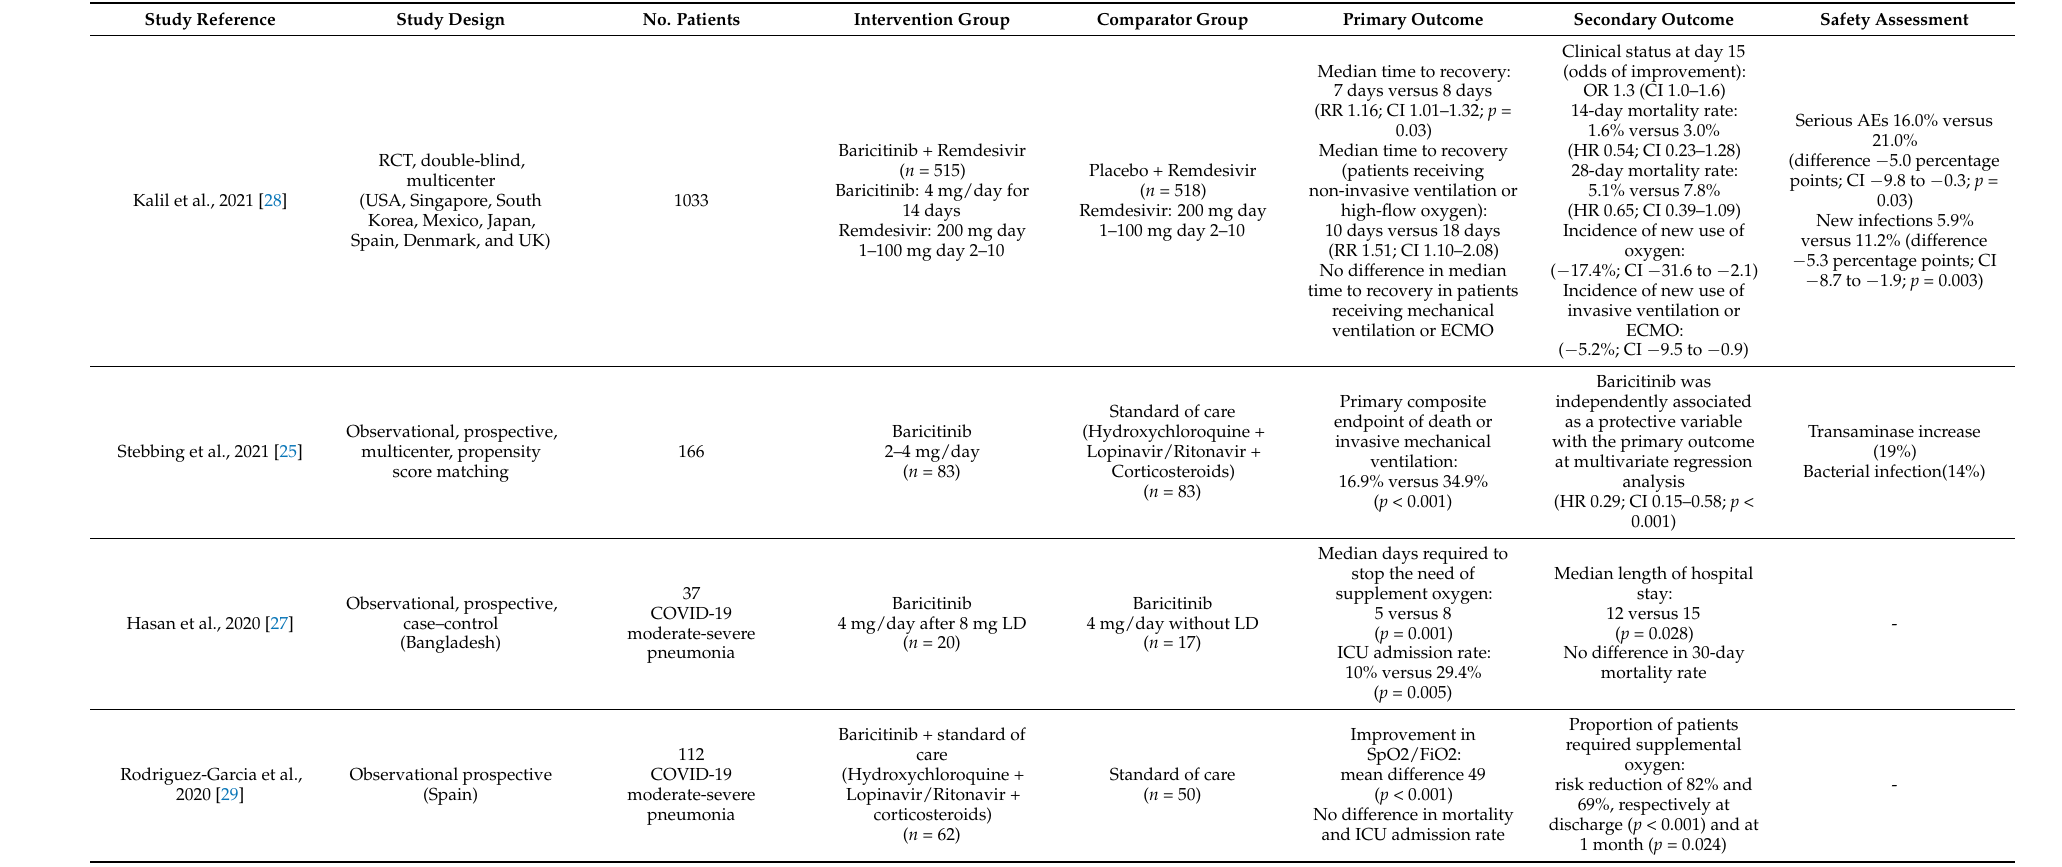
Table 2. Summary of the clinical studies investigating efficacy and safety of baricitinib in COVID-19